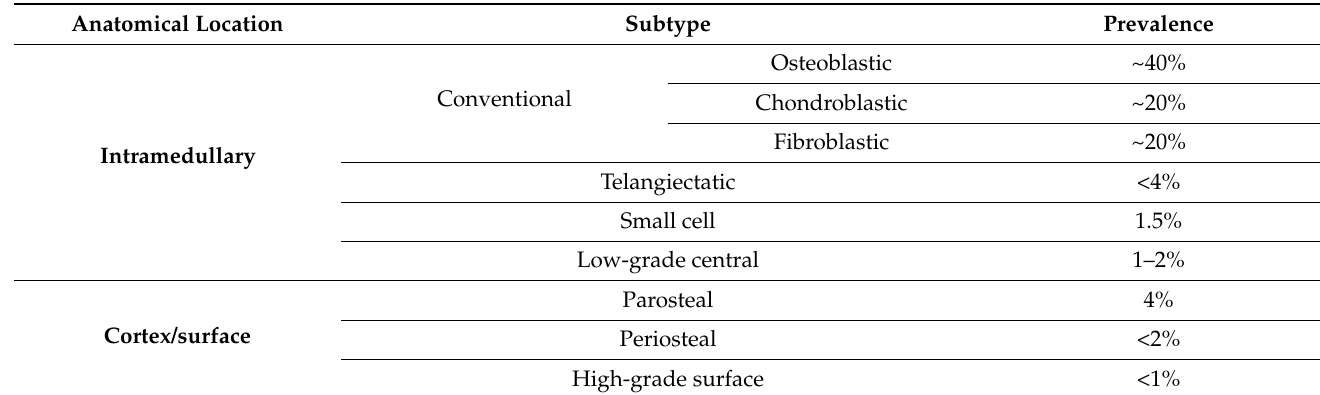
Table 1. The most common subtypes of OS